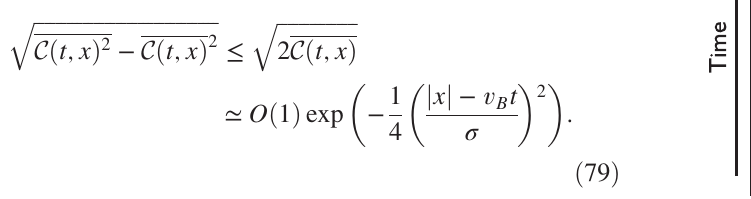
¯ P maps to the partition